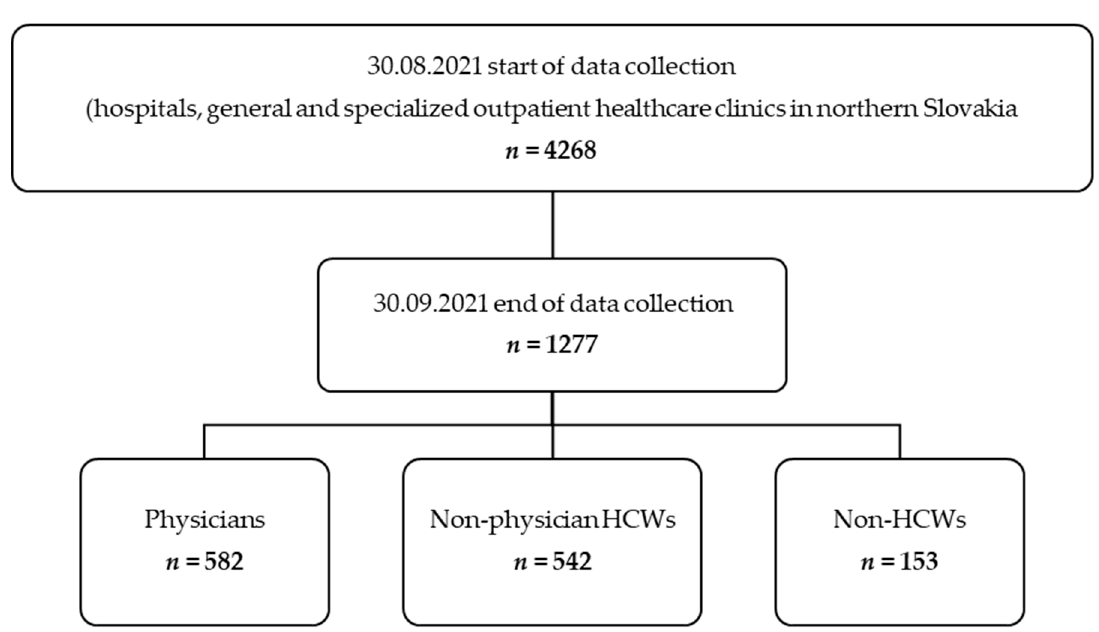
Figure 1. Process of data collection.